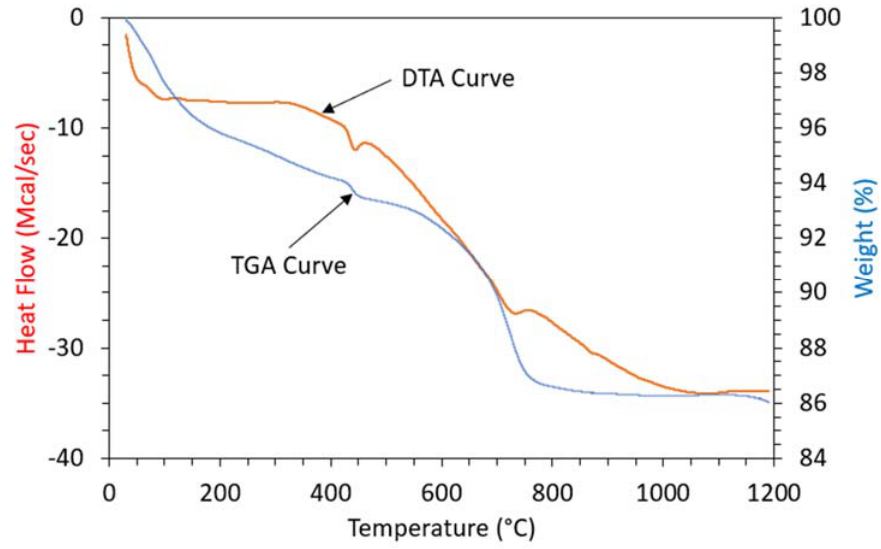
Figure 10. Thermal Analysis of Control Specimen.